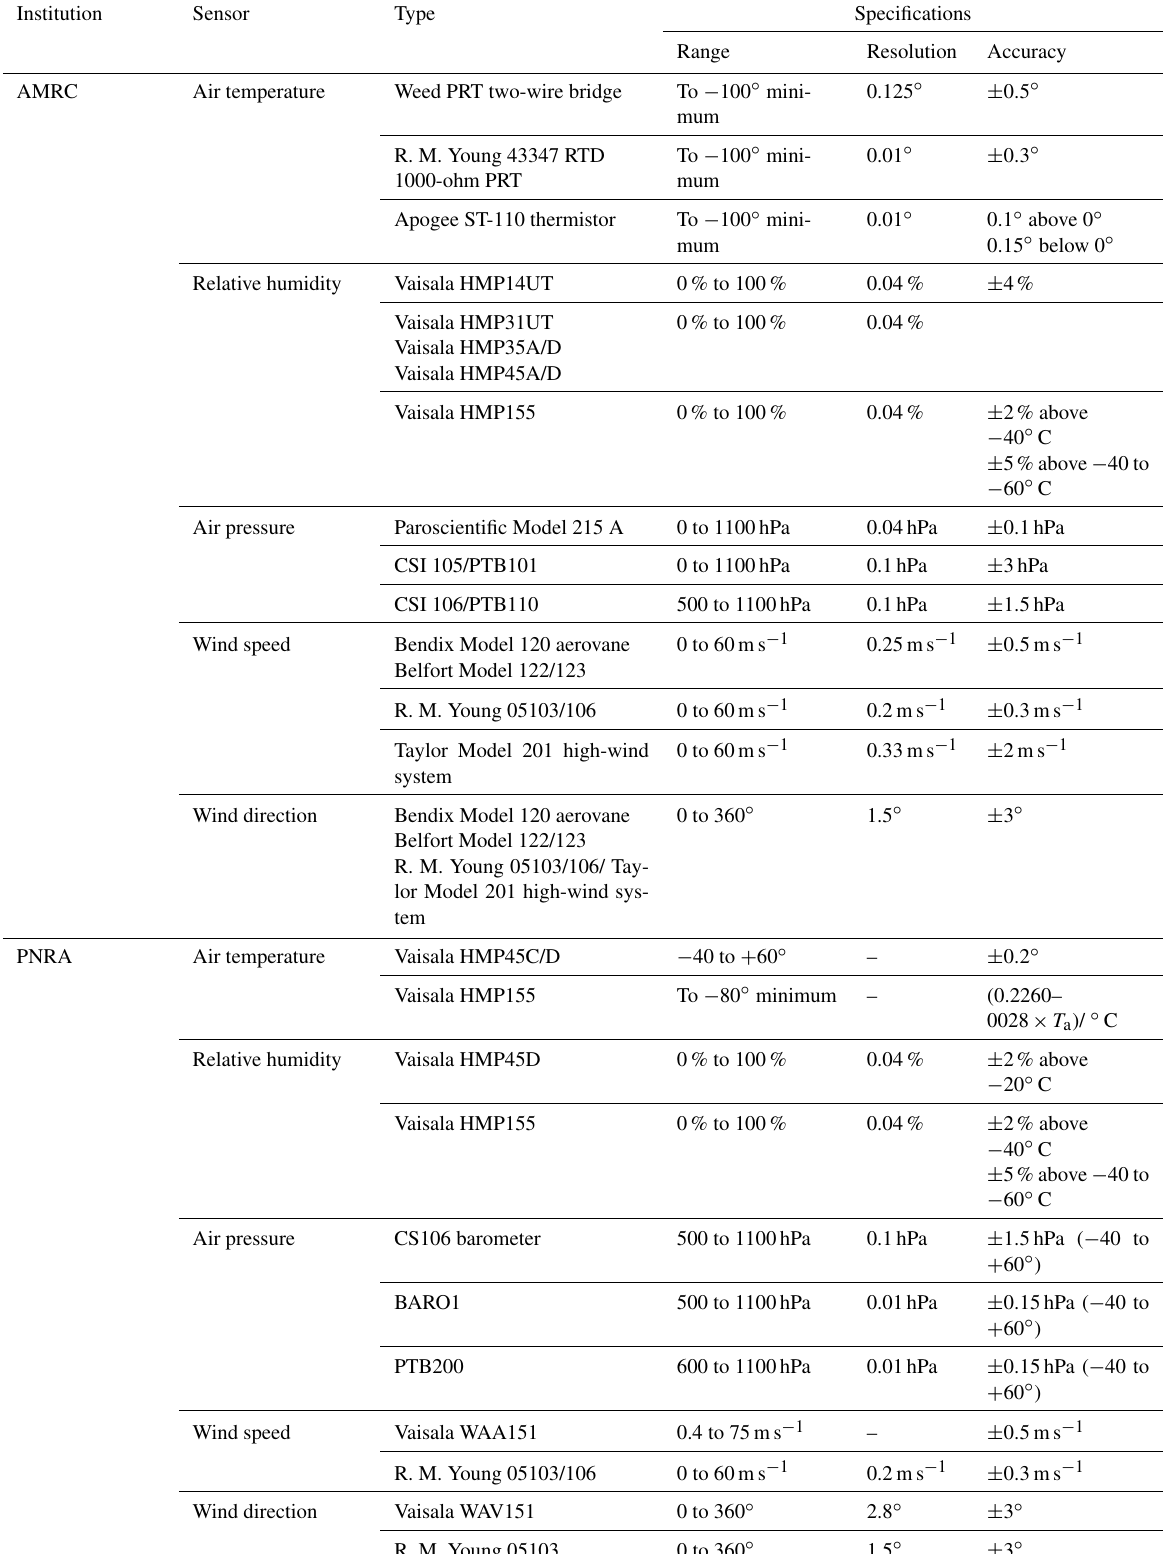
Table 1. The sensor types used on Antarctic automatic weather stations and the technical specifications.